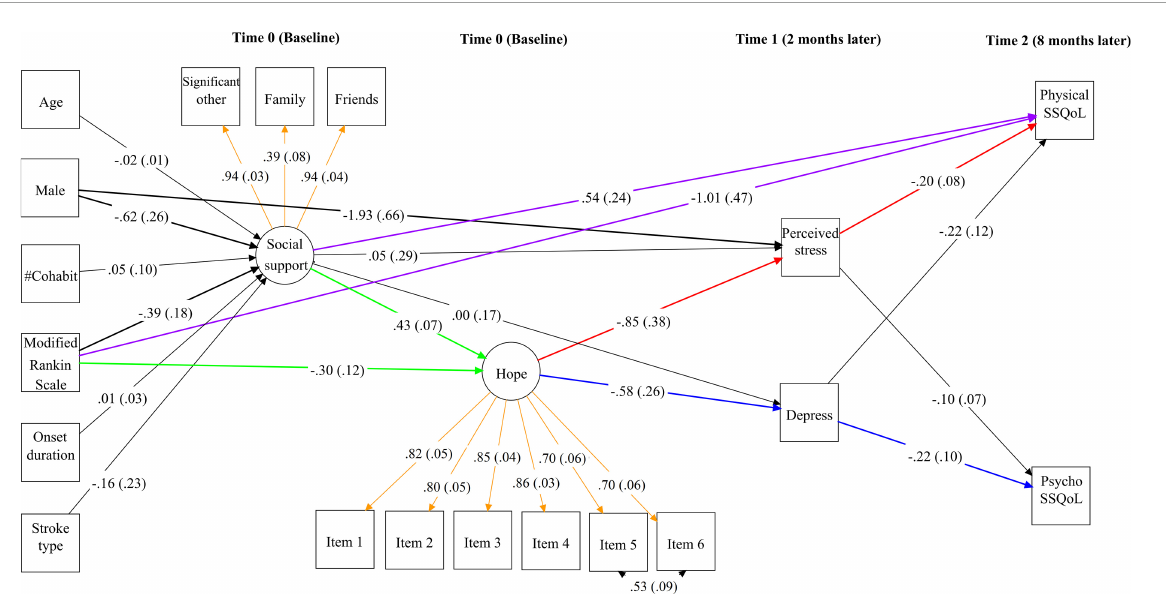
FIGURE1 Unstandardized path coefficients from Time 0 social support and hope to Time 2 stroke-specific quality of life (SSQoL) via Time 1 perceived stress and depression in the partial cascading model. Significant paths among the study variables are highlighted in bold. Standard errors are shown in parentheses. The direct effects of functional impairment and social support on hope are highlighted in green and those on physical QoL are highlighted in purple. The indirect effects of hope on physical QoL via perceived stress and on psychosocial QoL via depression are marked in red and blue, respectively. Standardized factor loadings of social support and hope are shown in orange. For simplicity, the baseline measures of the QoL and psychological variables are not shown in this figure.